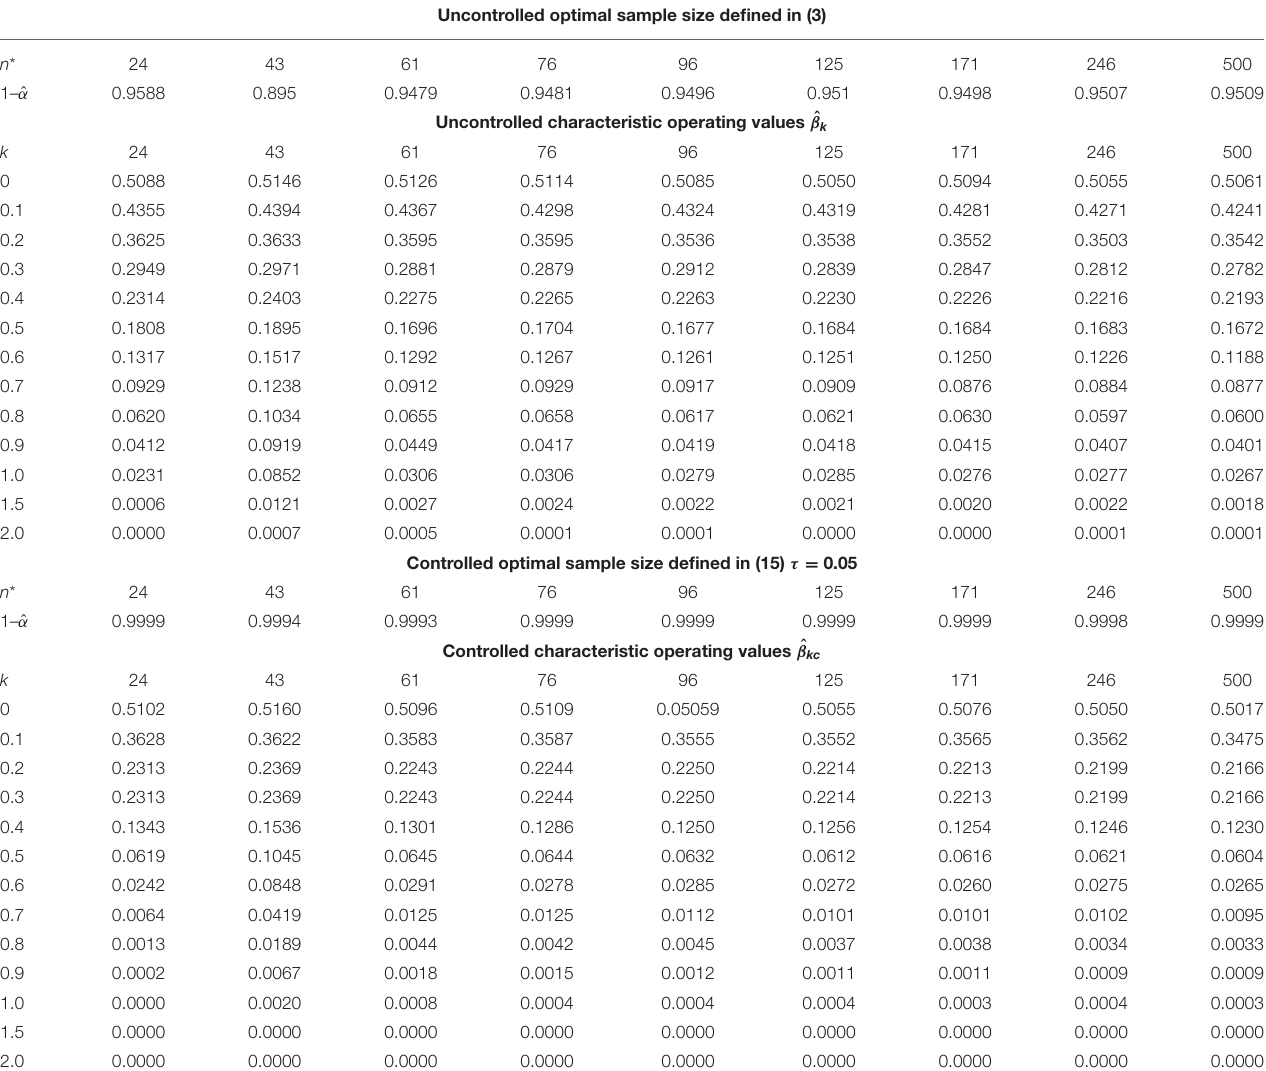
15 , γ 0.5 , α 0.05 , µ = = =